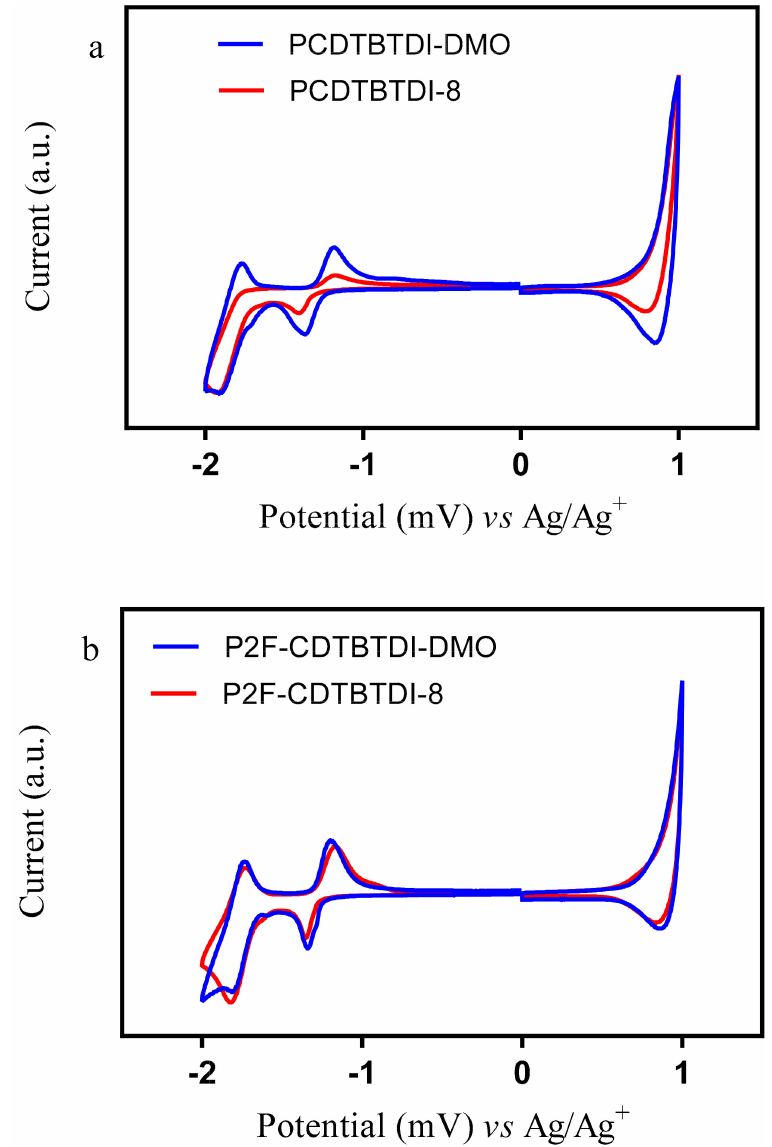
Figure 2. Cyclic voltammograms of ( a ) PCDTBTDI-DMO and PCDTBTDI-8; ( b ) P2F-CDTBTDI-DMO and P2F-CDTBTDI-8 on Pt electrode in Bu 4 NClO 4 / CH 3 CN at 100 mV /